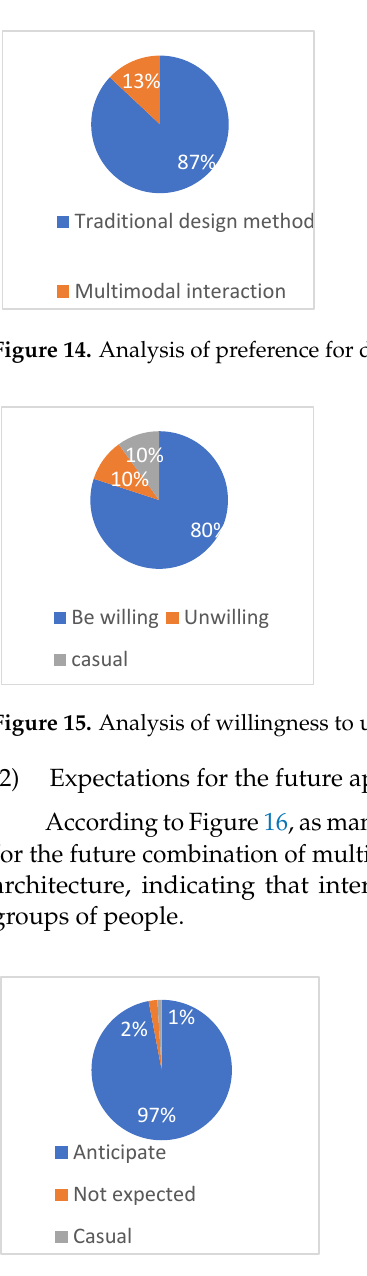
Figure 16. Interviewees’ expectations for the application of multimodal interactive technology in plant landscape in the future .